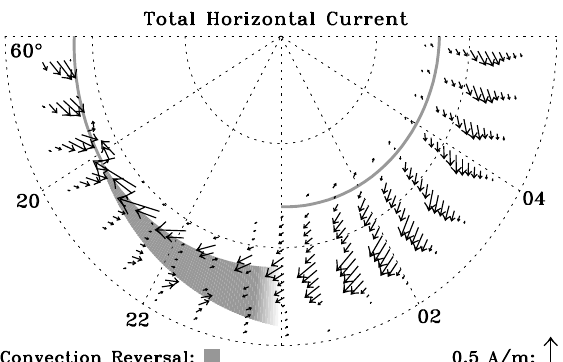
Fig. 6. Total height integrated horizontal currents during the ex- pansion phase through early recovery phase (wedge phase) of a classical auroral substorm from the empirical model of Gjerloev and Hoffman (2002). The shaded area indicates the Harang re- gion which during substorms is a region of weak meridional electric